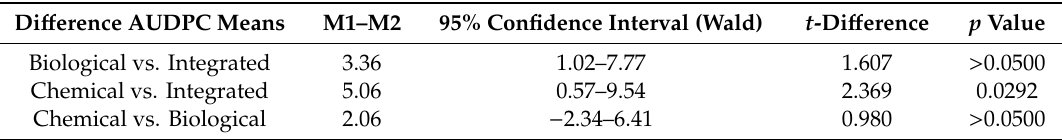
Figure 5. Control of ToLCNDV in zucchini under chemical, biological, and integrated management. Table 5. Mean values of area under the disease progress curve (AUDPC) of ToLCNDV-symptomatic plants in experimental zucchini greenhouse compartments.